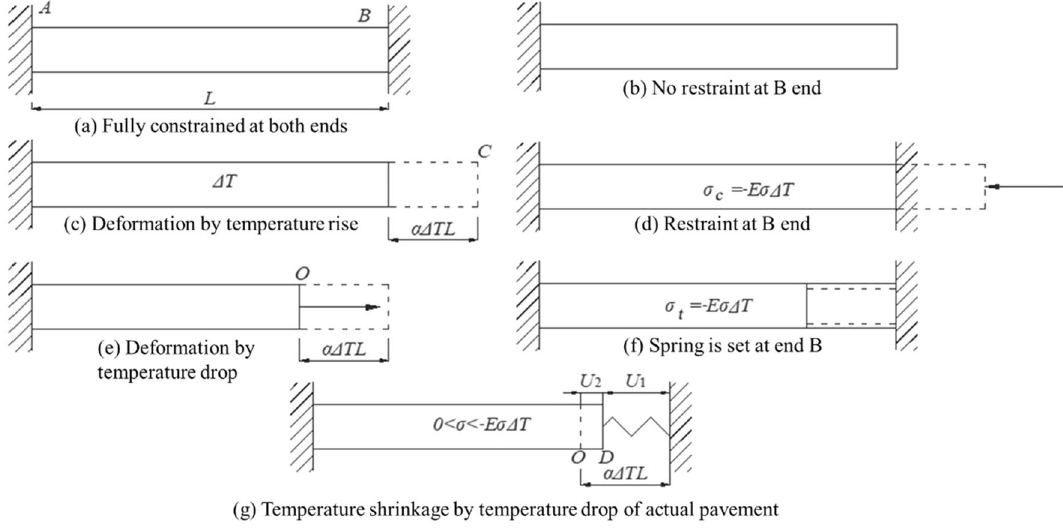
Figure 1. Schematic representation of the temperature shrinkage deformation of the pavement